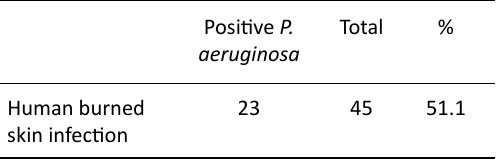
Table 1. Frequency of P. aeruginosa among burned